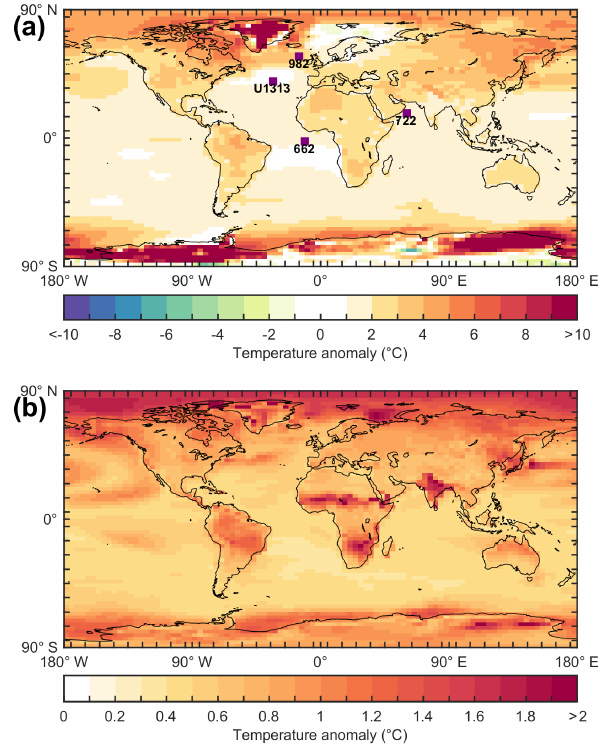
Figure 9. Emulated mean annual SAT ( ◦ C) for the 400ppmvCO 2 scenario, modelled using the lowice emulator. SAT is shown as an anomaly compared with the pre-industrial control simula- tion. (a) Mean annual SAT for modern-day orbital conditions. Also shown are the locations of the four ODP/IODP sites (pur- ple squares): Site 982 (North Atlantic; Lawrence et al., 2009), Site U1313 (North Atlantic; Naafs et al., 2010), Site 722 (Arabian Sea; Herbert et al., 2010) and Site 662 (tropical Atlantic; Herbert et al., 2010). (b) Standard deviation of mean annual SAT for the pe- riod 3300–2800kyrBP (late Pliocene), also taking into account the emulator posterior